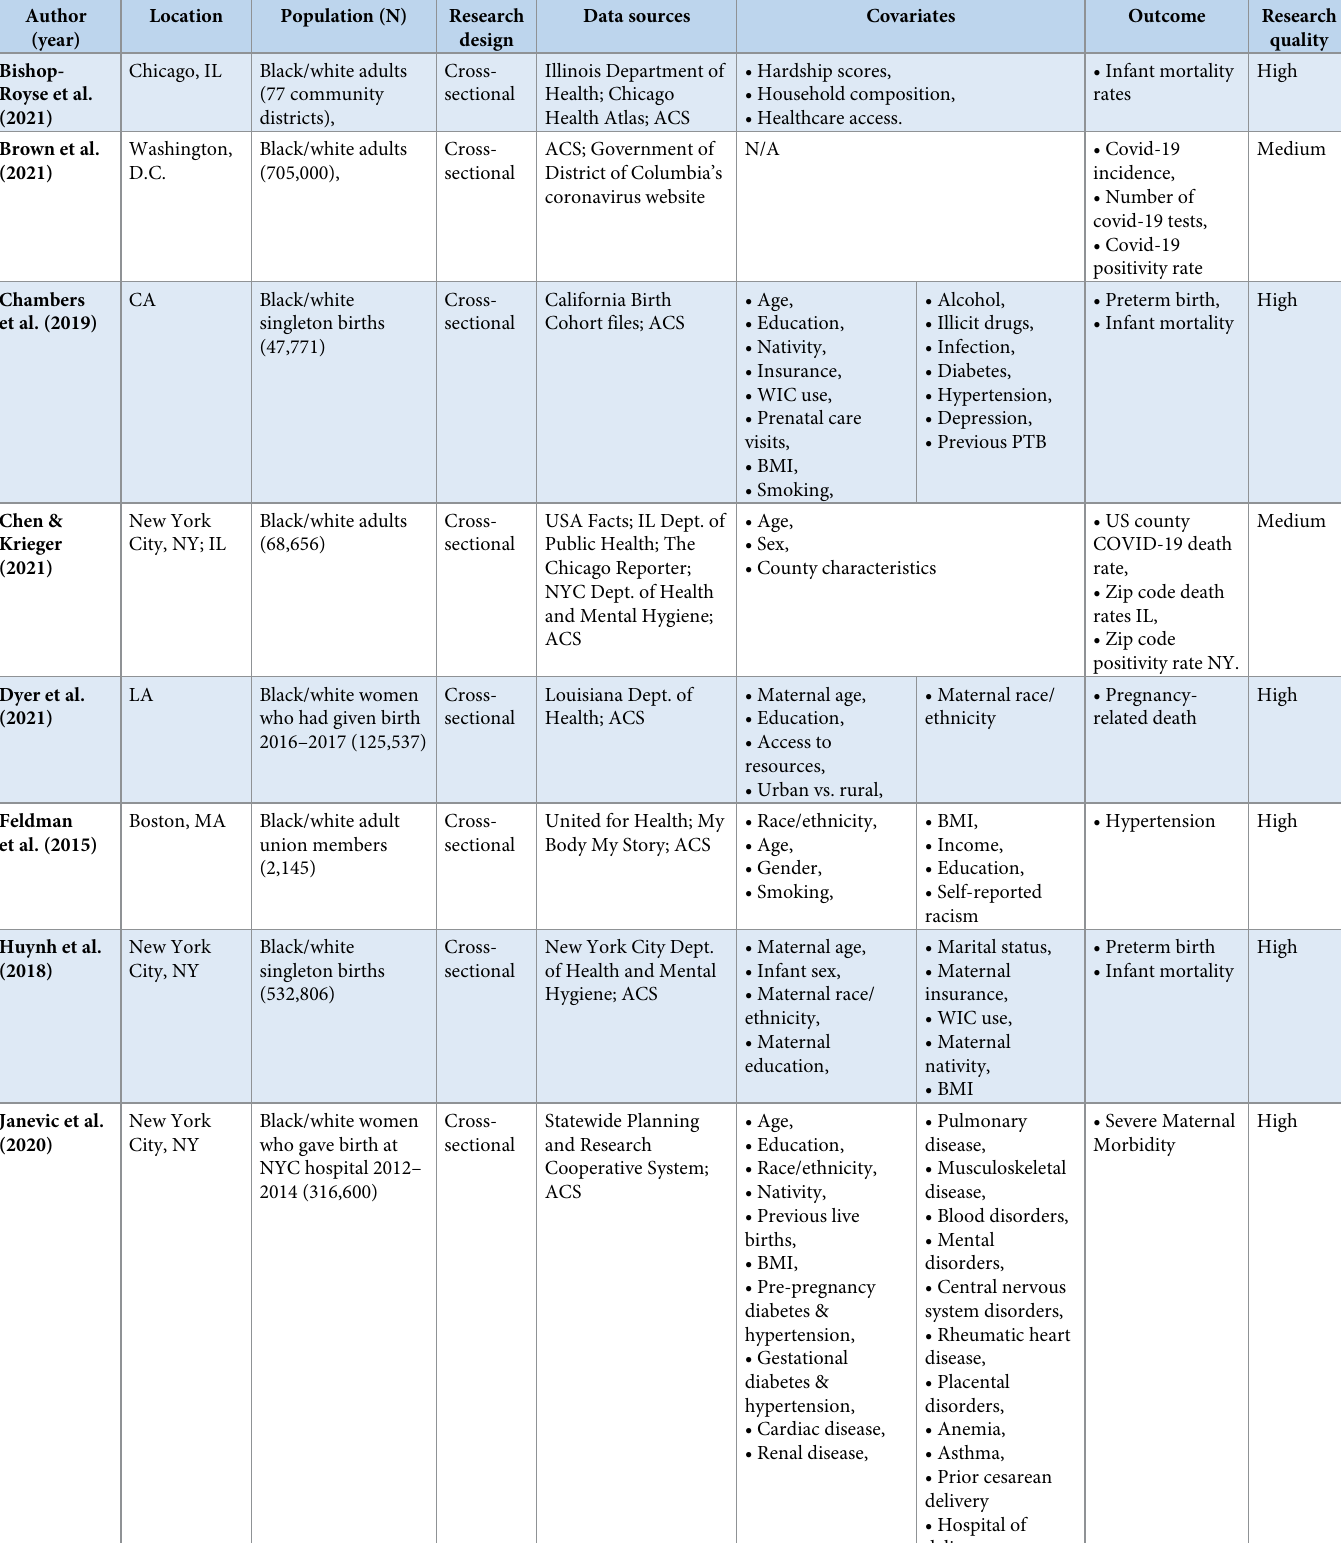
Table 1. Study characteristics of the reviewed